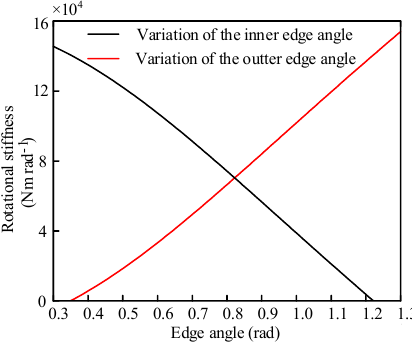
Figure 5. Rotational stiffness variation along with edge angles.